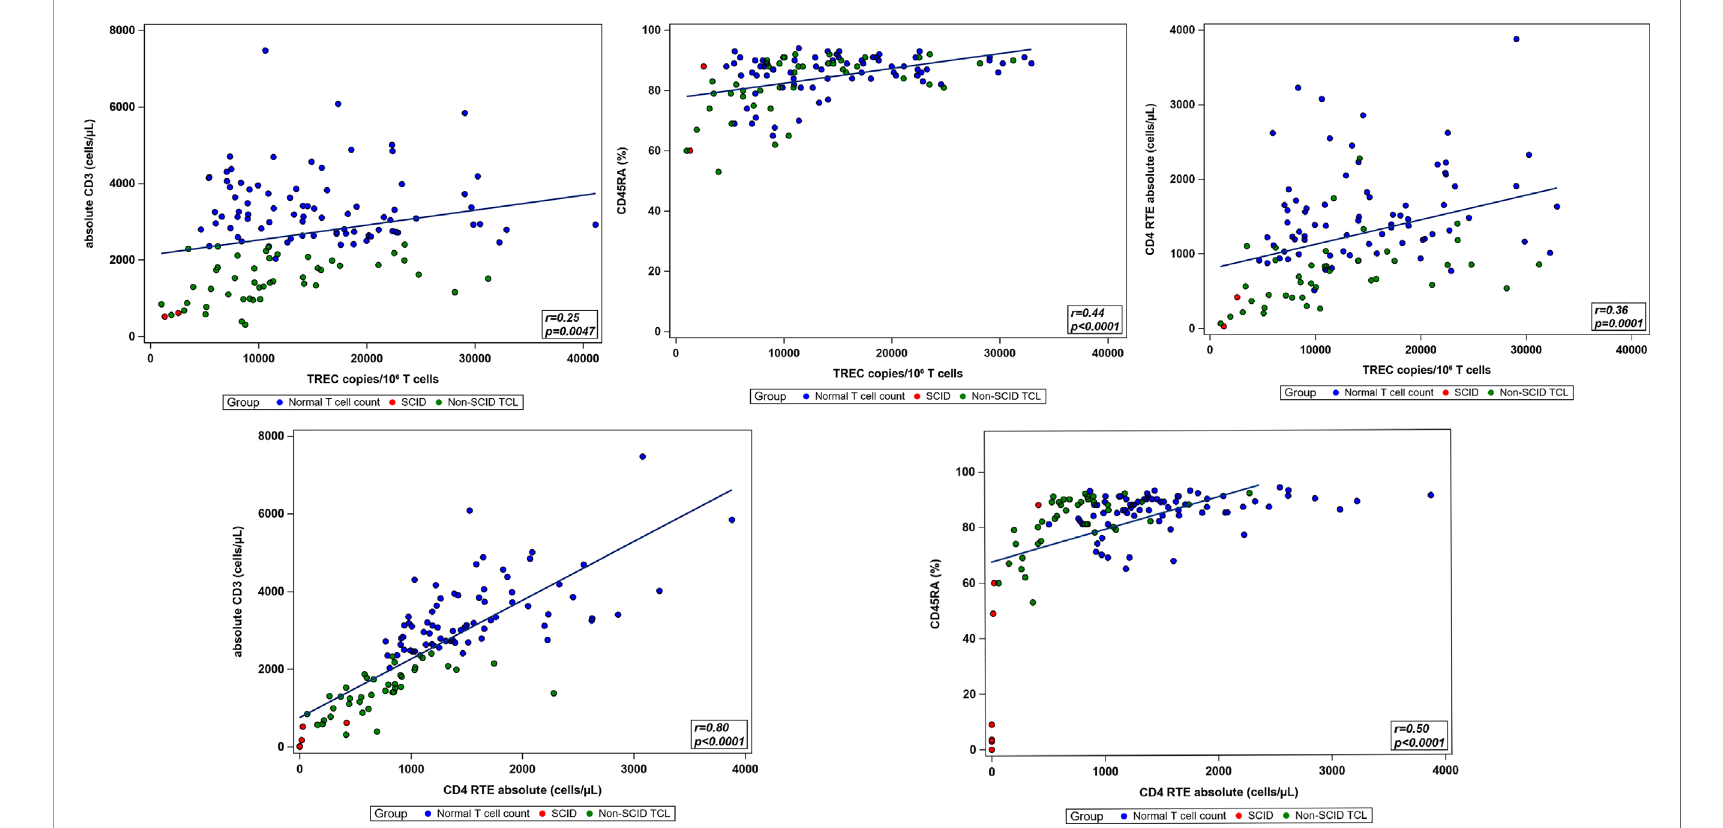
FIGURE 4 | Pairwise correlations between immunologic parameters of